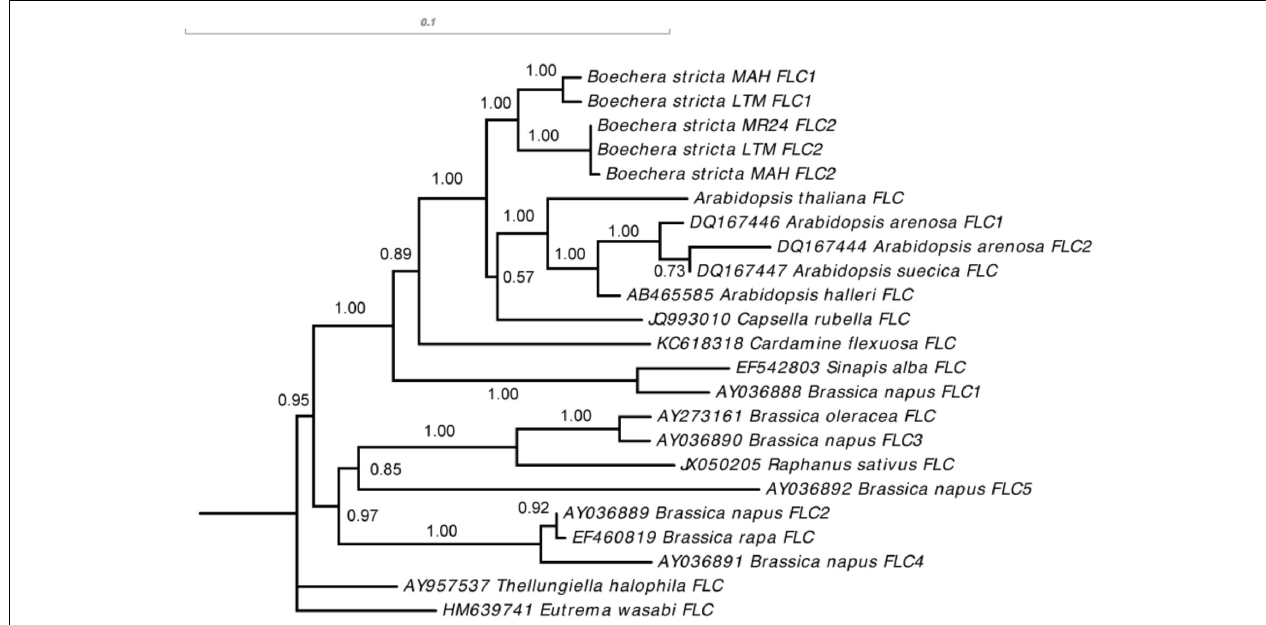
FIGURE 5 | Phylogenetic reconstruction of FLC coding sequences in Brassicaceae, showing that the gene duplication event creating BsFLC1 and BsFLC2 in Boechera stricta happened after the divergence between Boechera and Arabidopsis . The number above each internal branch represents posterior probability from Bayesian inference method. For sequences obtained from GenBank, accession numbers are labeled in front of species names.